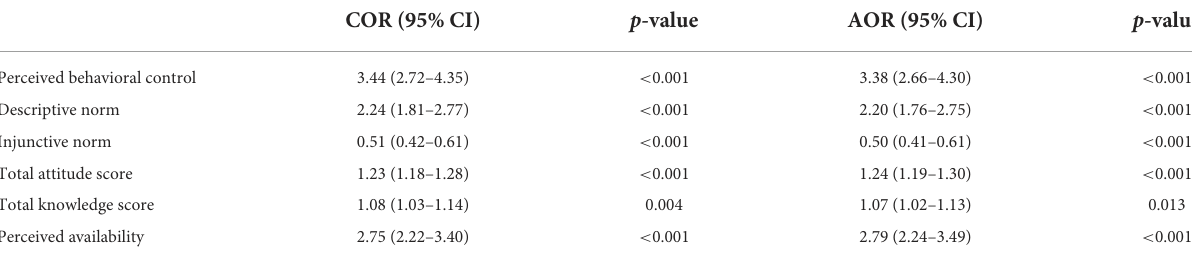
TABLE 3 Univariate analysis of key constructs with cannabis use intention.